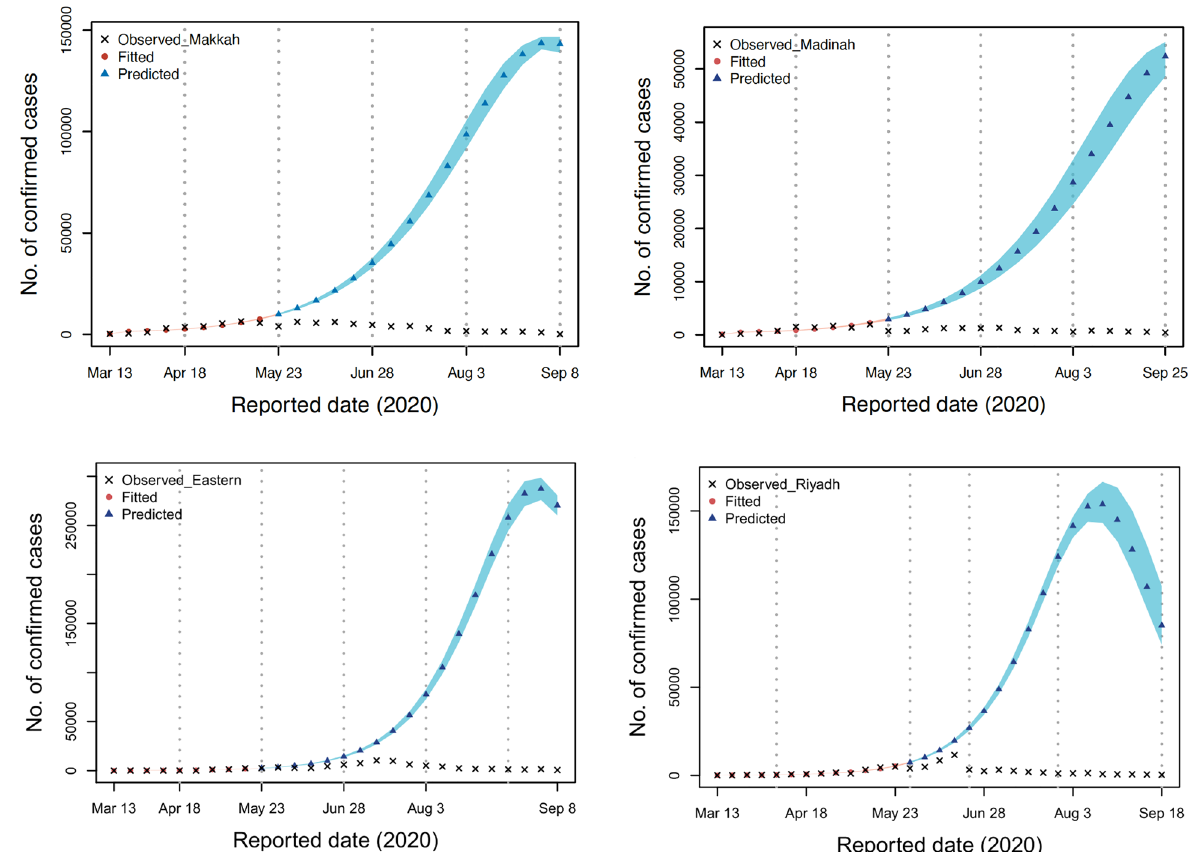
Figure 6. For each of the four regions of interest, the relevant variables were identified by first fitting the data from each area and then making predictions using the parameters from period 2. Each of the four regions of interest was done separately.